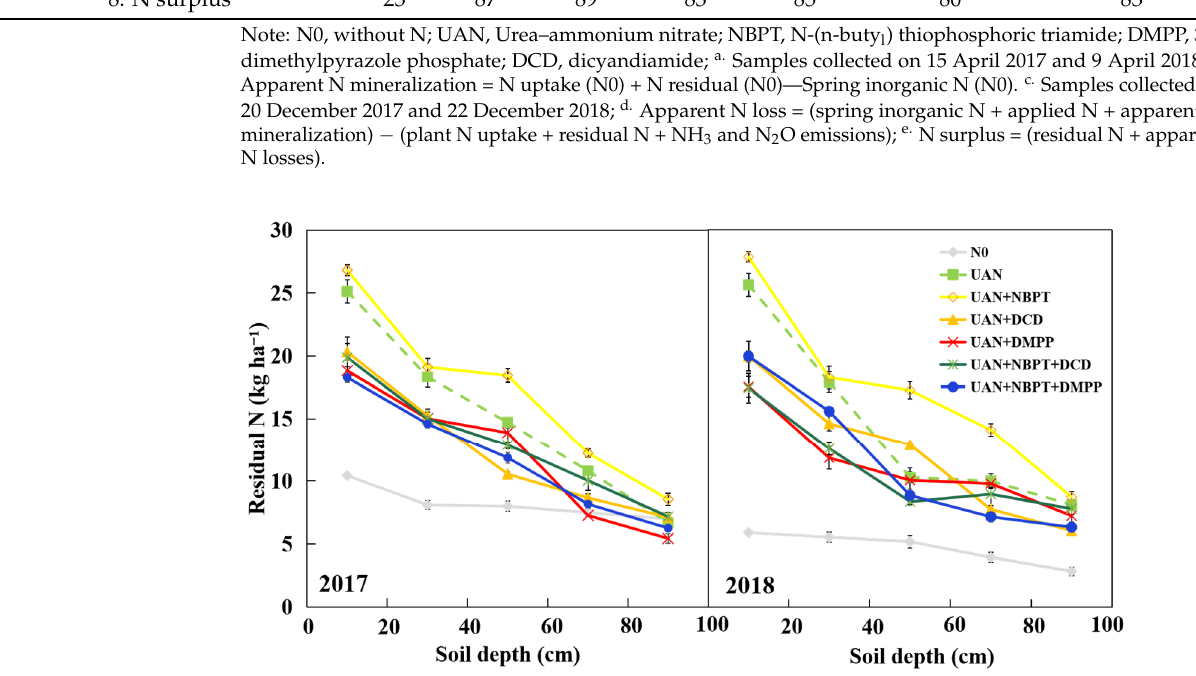
Figure 5. Distributions of soil residual nitrogen in the 0–100 cm soil; bars are standard error of the mean. Table 2. Nitrogen budgets (kg ha −1 ) in 2017 and 2018.